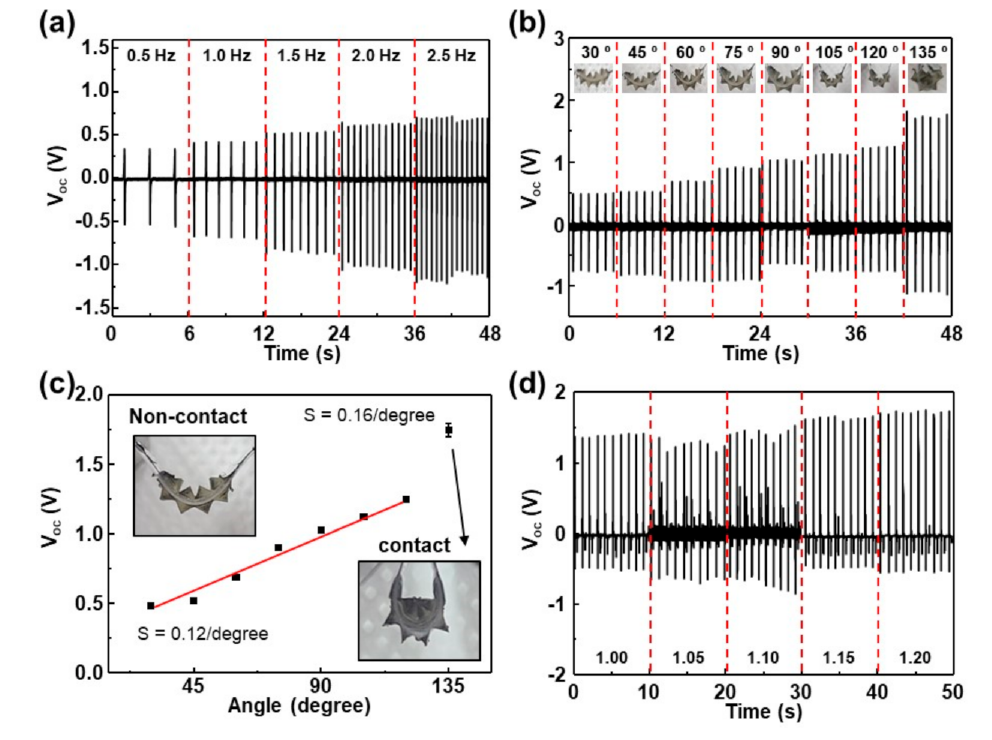
Figure 3. ( a ) Output voltages of the sensor with different frequency. ( b , c ) Output voltages of the sensor with bending angles and sensitivity. ( d ) Output voltages of sensor with bending under strain from 1.00 to